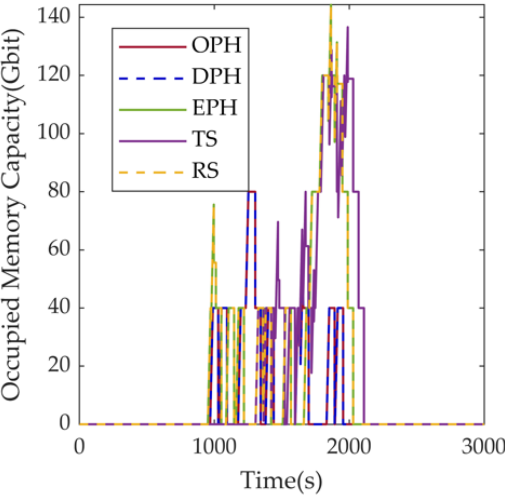
Figure 17. Satellite occupied memory capacity diagram of a single condition in the third group.